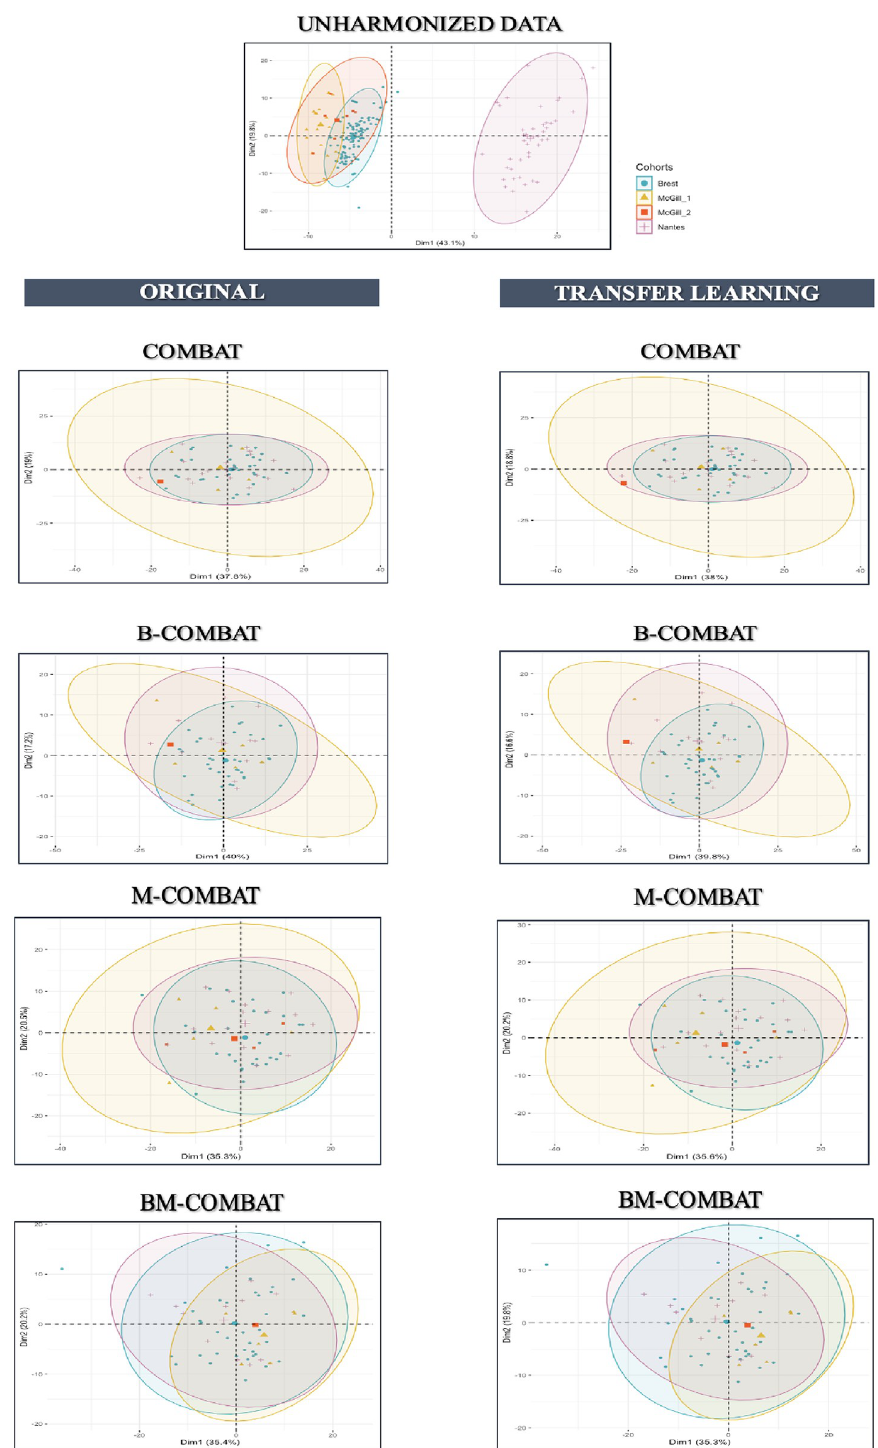
Fig 4. PCA and summary distribution in Experiment 1 in FDG PET. Scatter plots of top 2 principal components of the radiomic features across the three labels (centers) using data transformed with the 4 versions of ComBat (using R (3 . 5 . 1) and R Studio (1 . 1 . 456 , RStudios Inc ., Boston , MA) https://cran.r-project.org/).